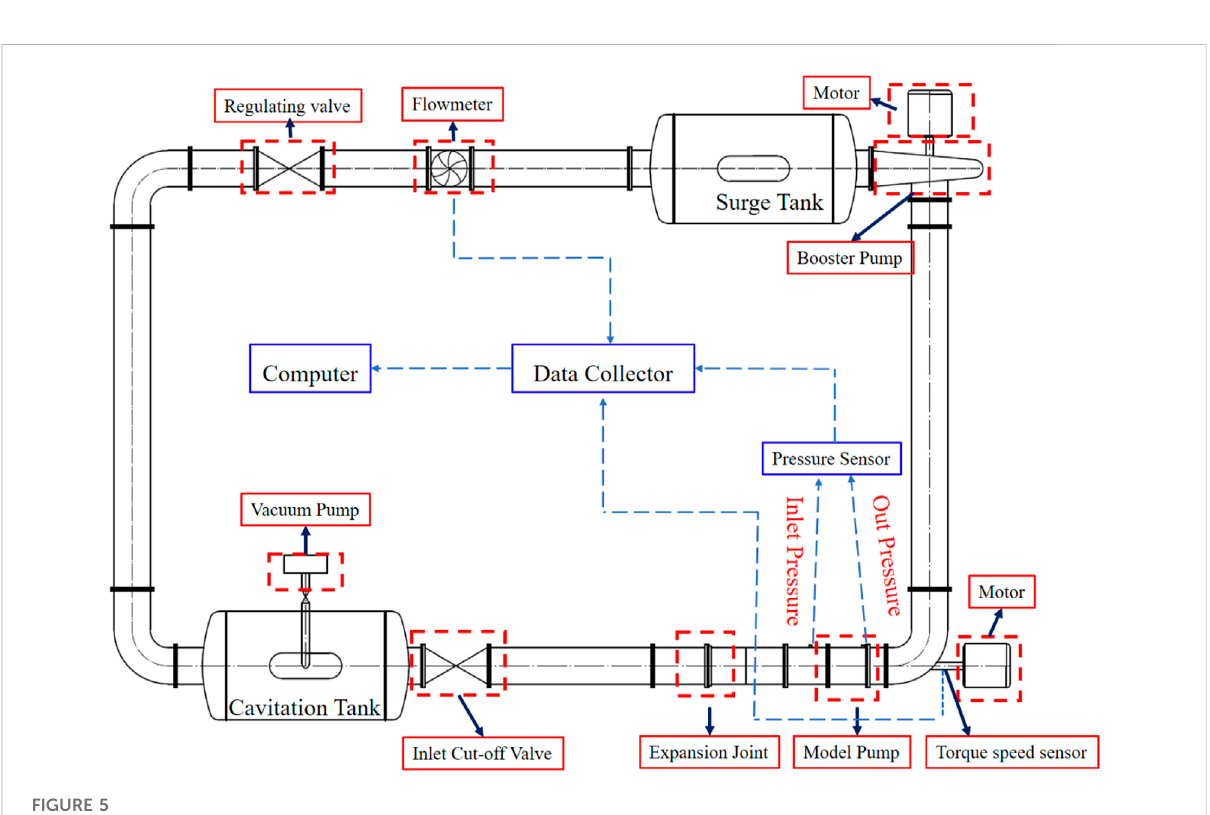
FIGURE 5 Schematic map of the hydraulic test